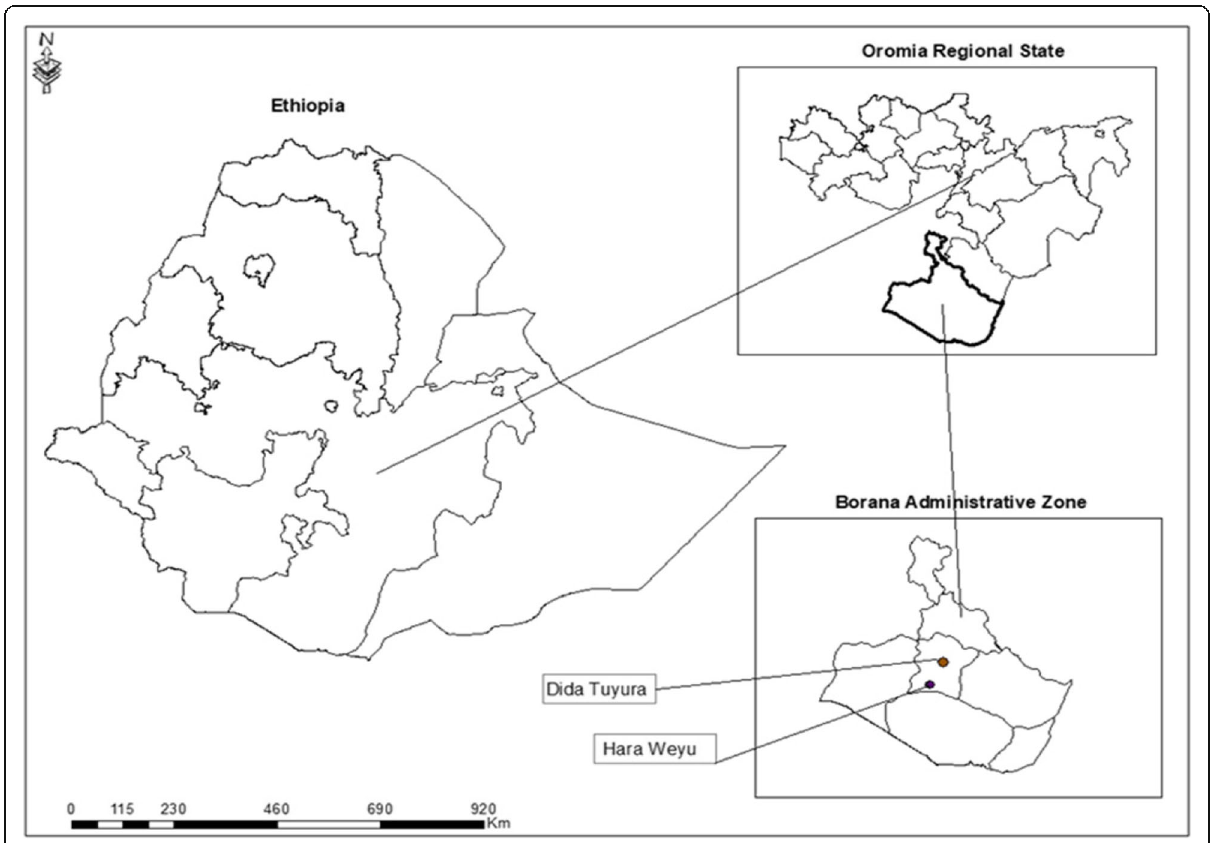
Fig. 1 Map of Ethiopia showing the study area